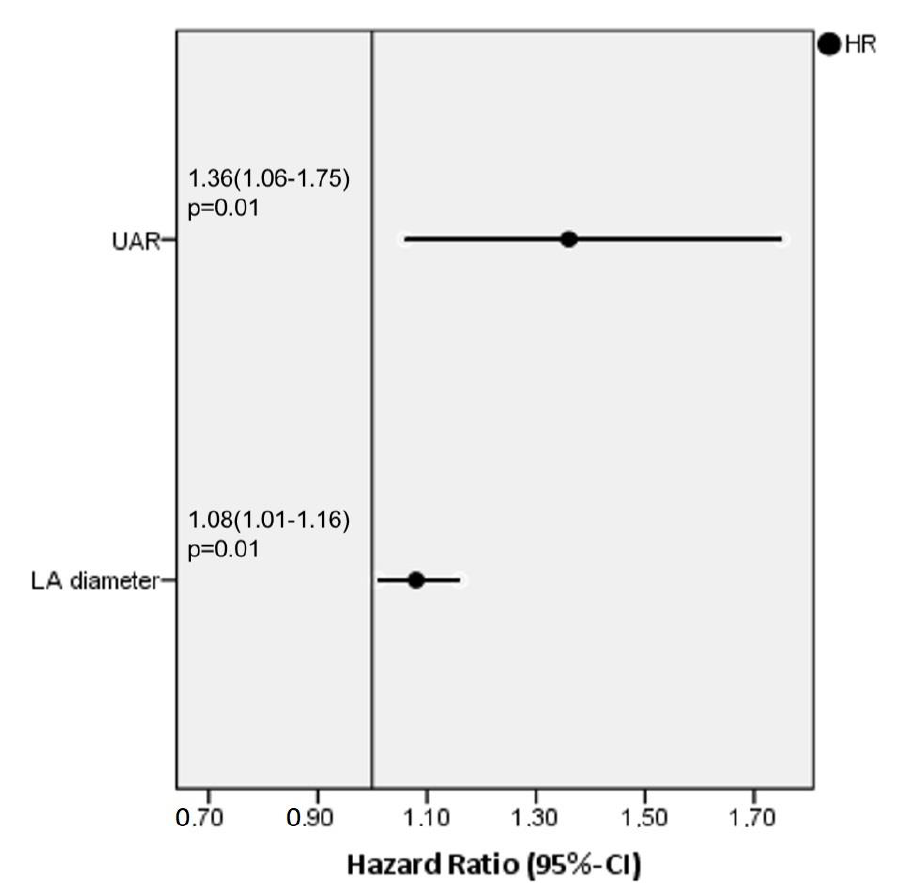
Figure 1. Forest plot graphic of independent predictors of atrial fibrillation recurrence after ablation according to the multivariable regression analyses. Table 2. Multivariable regression analyses of the parameters which were found to be correlated with recurrence after univariable regression analyses.